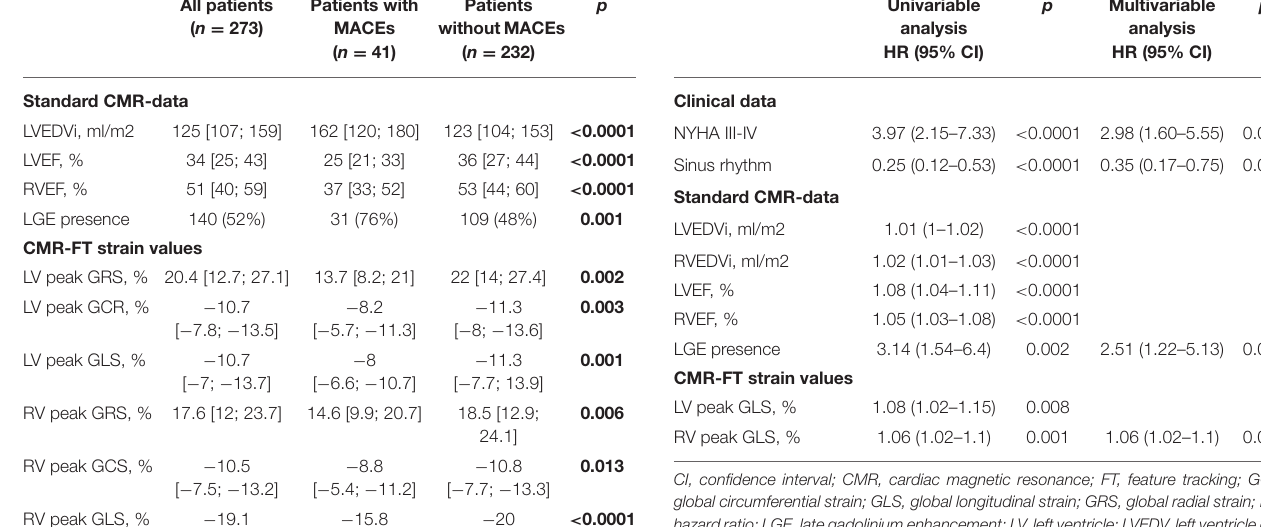
TABLE 3 | CMR-FT model. Uni- and multivariable Cox analysis to predict MACEs (primary end-point) * . Univariable